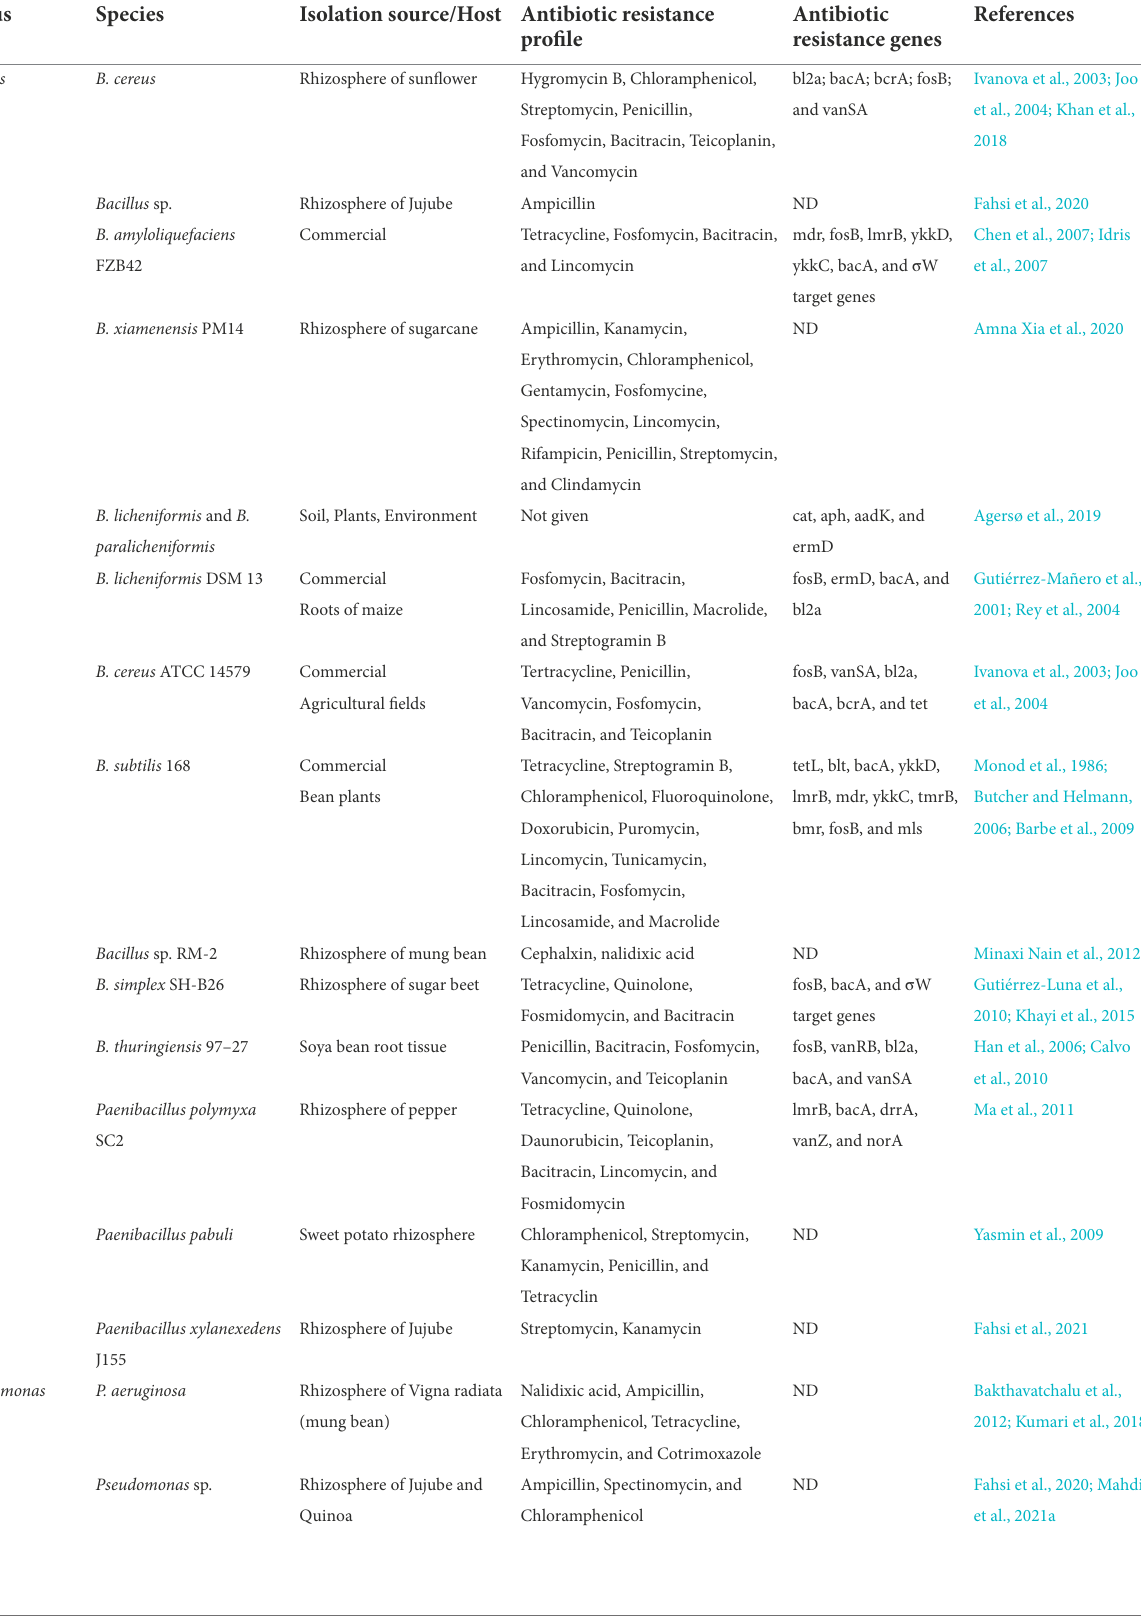
TABLE 1 A list of antibiotic resistance patterns of some declared PGPB strains and respective/putative identified ARGs.